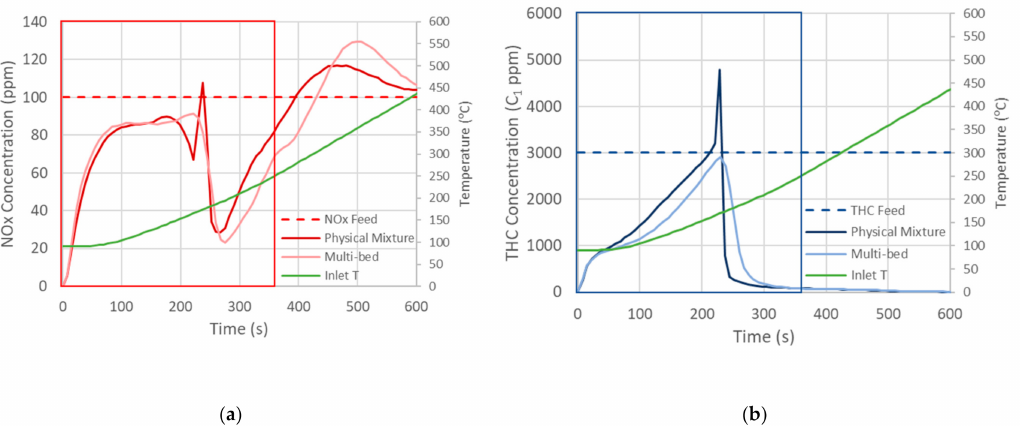
Figure 10. Time-based reactor effluents for ( a ) NO and ( b ) THC during temperature ramps for physical mixture (PNA + HCT + DOC) and multi-bed (PNA → HCT → DOC) reactor beds; temperature plotted on right y -axis. Boxes indicate area that is below 250 ◦ C and is the primary focus for reactivity